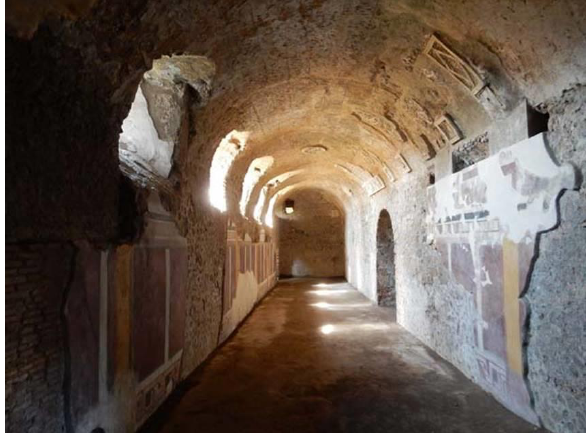
Figure 7. House of the Cryptoporticus, large indoor corridor roofed by a concrete barrel vault covered with frescoes.